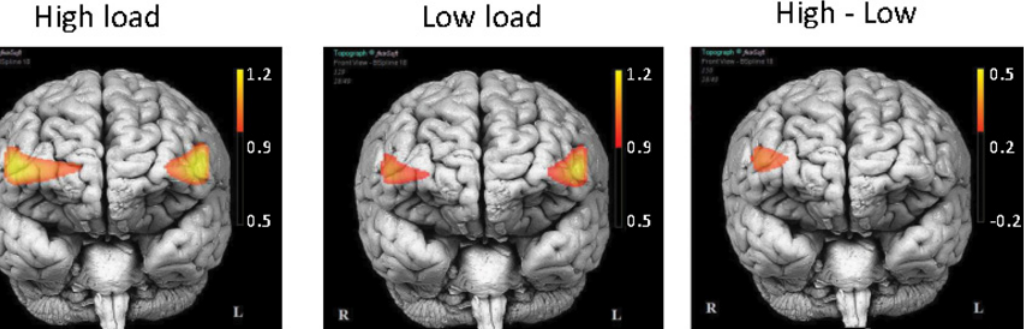
Fig 7. Activation maps according to the level of difficulty. Units are in μ mol . l − 1 . Both high and low load conditions elicit bilateral DLPFC activities. The high load minus low load subtraction map (High — Low) shows significantly greater activation of the right DLPFC. Activations shown 14 s post-stimulus